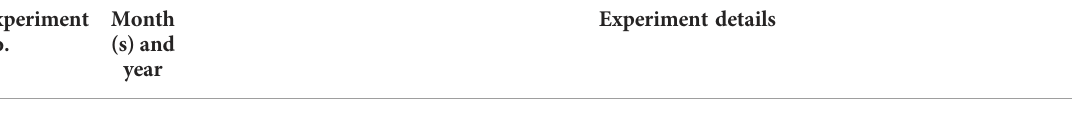
TABLE 1 Summary of the experiments performed at Xiaotangshan and